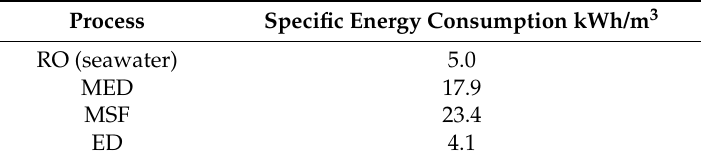
Table 2. Specific energy consumption (SEC) of different processes (based on